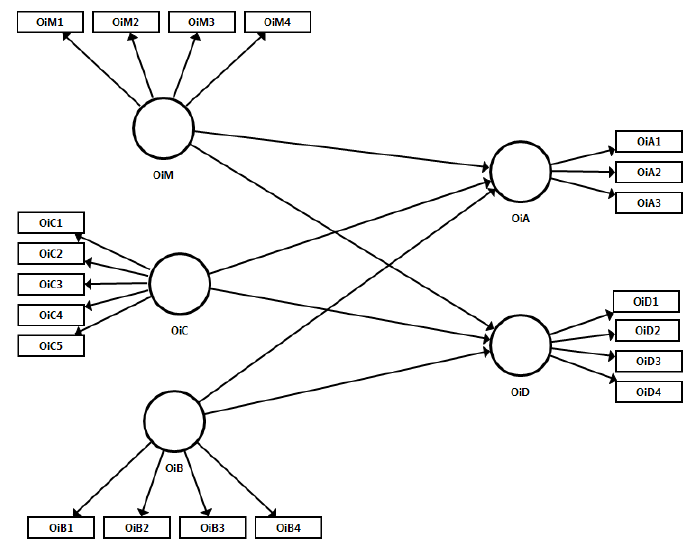
Figure 2. The second-order model.